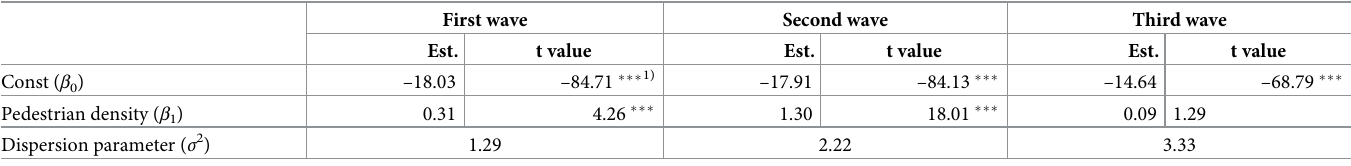
Table 2. Parameter estimates. See Fig 15 for the fitting on the number of